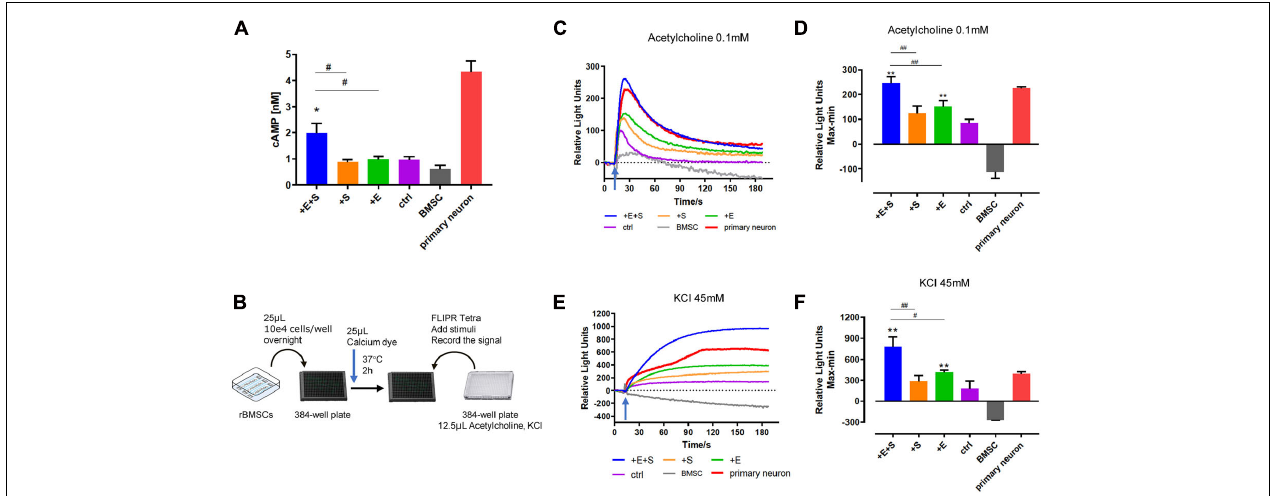
FIGURE 5 | Electrical field and cyclical stretch co-stimulation enhanced the rBMSC-derived neural cell function. (A) cAMP level in differentiated cells under static condition (ctrl), strain (+S), electrical stimulation (+E), and co-stimulation (+E +S) ( n = 9). (B) Schematic of the calcium test process. Calcium signaling triggered (arrows indicate the time point of adding inducer) by acetylcholine (0.1 mM) (C,D) and KCl (45 mM) (E,F) . The primary neurons cultured in vitro for 7 days were used as a positive control, and the undifferentiated BMSCs were the negative control. Representative tracings of calcium signal record by FLIPR after adding acetylcholine (C) and KCl (E) . Statistical analysis of the peak amplitude (D,F) . * p < 0.05, ** p < 0.01 (compared with static control), # p < 0.05, ## p < 0.01 (ANOVA, n =